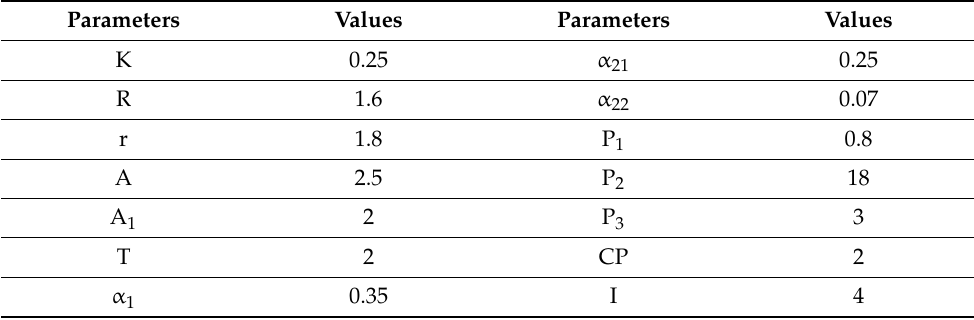
Table 8. Initial parameter